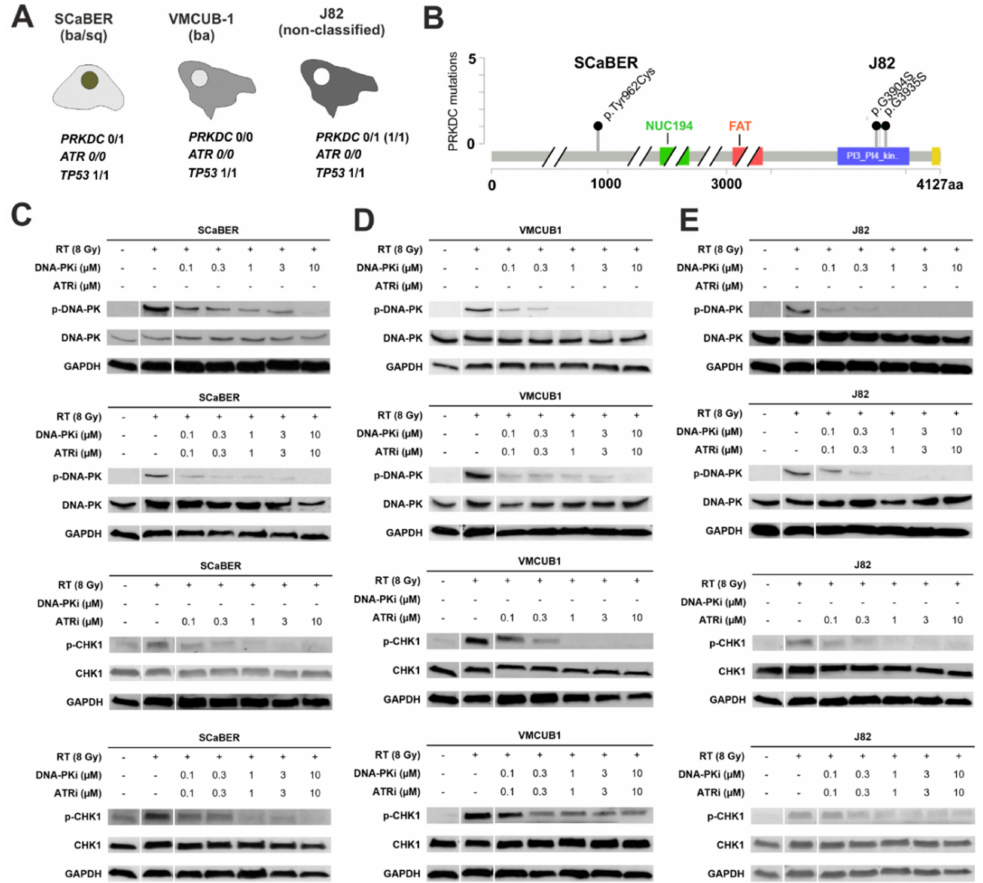
Figure 2. Inhibition of DNA-PK and ATR impairs downstream DDR signaling of different bladder cancer cell line models. ( A , B ) In vitro models used for drug response studies. NGS-based exome sequencing revealed a monoallelic PRKDC mutation of unknown functional significance in squamous- like SCaBER and two alterations in urothelial J82 cells. The urothelial basal-type VMCUB-1 cell line showed no PRKDC alteration. The ATR wild-type and biallelic TP53 mutations were present in all cell lines. ( B ) The type and position of the monoallelic PRKDC (DNA-PKcs) alterations of SCaBER and J82 cells are illustrated in a lollipop plot. The mutations found in SCaBER and J82 are of unknown significance. In J82 cells, the mutation of DNA-PKcs was located in the PI3_PI4 kinase domain (p.G3904S) close to the predicted binding site of AZD7648, potentially involving interaction with the amino acids at the positions Leu3751, Arg3737, Trp3805, Leu3806, Asn3926, and Ile3938 [32]. The identified mutation of DNA-PKcs in SCaBER cells was located at the N-terminal to the FAT domain, which is known to comprise a predominantly helical solenoid HEAT-repeat domain of variable length that mediates protein-protein interaction [33]. ( C – E ) Phospho-western blots were performed to assess activation of DNA-PK and ATR mediated pathways upon irradiation (radiation dose = 8 Gy), as well as single and dual DNA-PK/ATR inhibition, in SCaBER, VMCUB-1 and J82 bladder cancer cells. Radiation of cells triggered activation of both DDR pathways (DNA-PK and ATR). In turn, phosphorylation of DNA-PK (Ser2056) and CHK1 (Ser317) was effectively blocked upon single/dual treatment of increased concentrations of AZD7648 and Ceralasertib. Please note: For the ATR pathway, the activation of downstream target CHK1 (Ser317) was analyzed since the phosphorylation of ATR at position Thr1989 was not significantly altered upon AZD6738 (Ceralasertib) treatment (see Supplementary Figure S3). ‘+’ and ‘ − ’ refers to the exposure or lack thereof to IR or